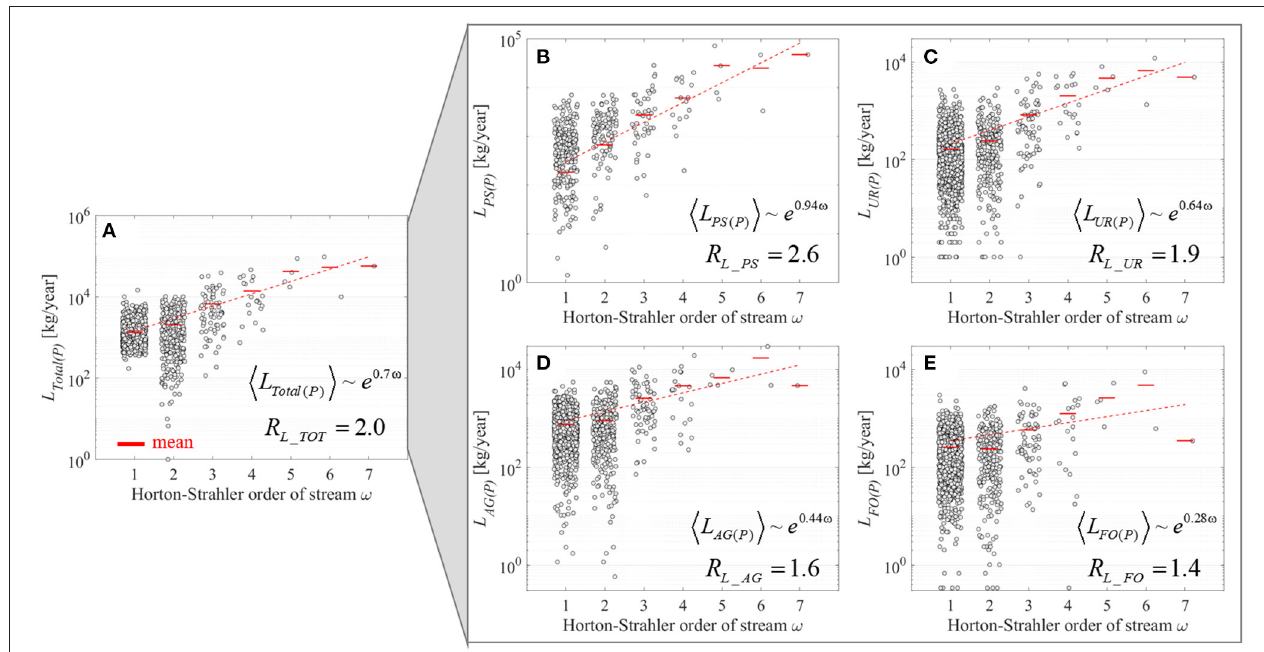
FIGURE 2 | Stream-order based distributions of P tot loads for the Weser River Basin. (A) Total P tot loads from both point- and diffuse-sources L Total ( P ) . (B) Reported P tot loads discharged from WWTPs L PS ( P ) . (C–E) Estimated P tot loads delivered from urban surfaces L UR ( P ) , agricultural areas L AG ( P ) , and forested/semi-natural areas L FO ( P ) , respectively. For a given stream-order ω , each gray dot indicates the estimated P tot loads from directly draining areas into a stream of the ω -th order. Mean of gray dots within the same ω are depicted as red bars, and their linear trends over ω are fitted on the semi-log plot. Hortonian scaling equations with exponent h , and the resultant Hortonian scaling ratios are embedded in each plot.